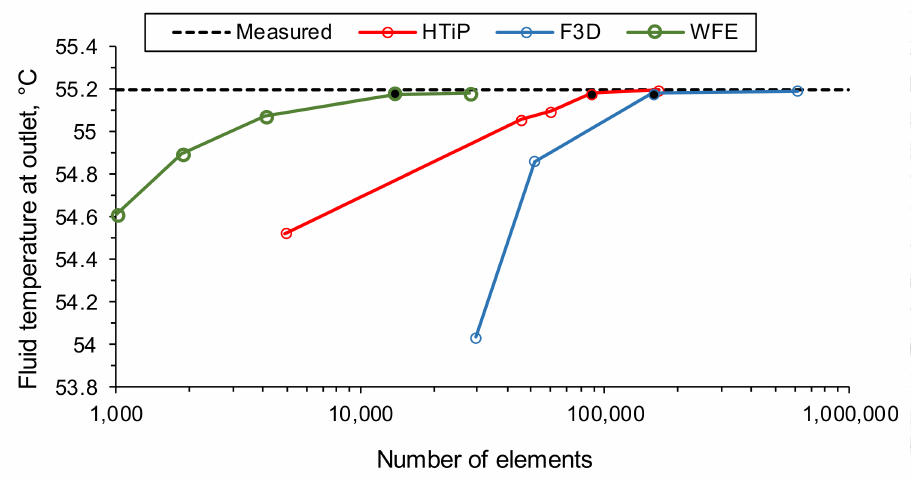
Figure 7. The results of the mesh sensitivity study comparing the fluid temperature at the BHE outlet after 21 days of heating for the HTiP, F3D, and WFE modelling approaches versus the measured value (black, dashed). The selected mesh is indicated with the black marker.